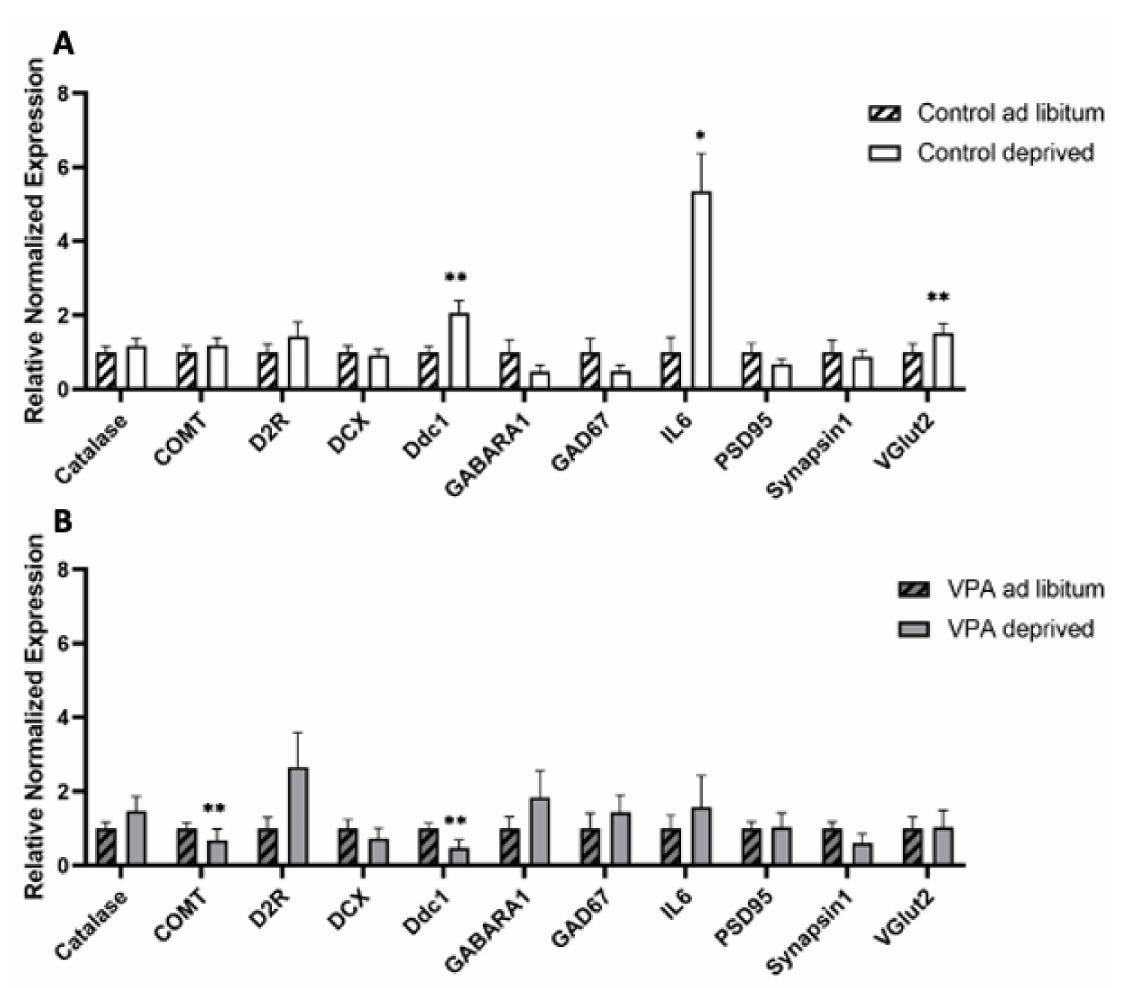
Figure 2. Gene expression changes in neurotransmitter receptors, oxidative stress and inflammatory markers analysed in ( A ) fed and unfed control animals and ( B ) fed and unfed VPA animals. COMT— Catechol-O-Methyltransferase, D2R—Dopamine Receptor D2, DCX—Doublecortin, Ddc1—DOPA decarboxylase, GABARA1— γ -aminobutyric acid type A receptor, GAD67—glutamate decarboxylase 1, IL6—Interleukin 6, PSD95—discs large MAGUK scaffold protein 4 (Dlg4),